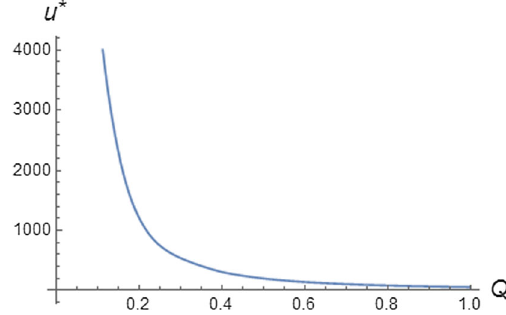
Fig. 8 For any Q ∈ [ 0 , 1 ] it is shown the corresponding u ∗ ( Q ) such that for u < u ∗ the Polymer BKL map on Q (116b) is monotonically decreasing. For a single iteraction it can be shown that for every Q < 0 . 96 the following Q (cid:11) < 1. The function u ∗ ( Q ) cannot be given in closed